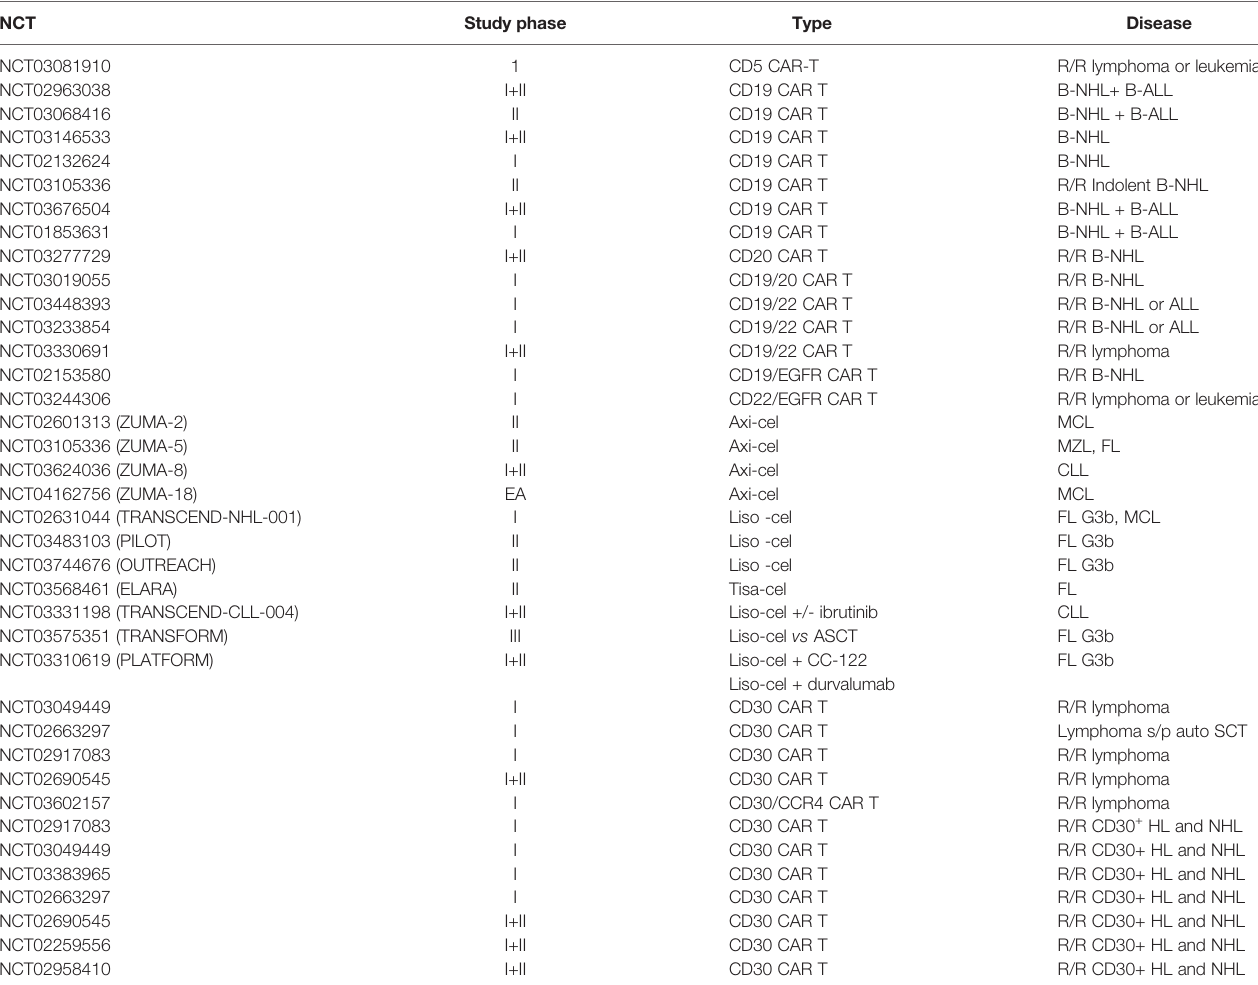
TABLE 3 | The clinical trials of CAR-T cell therapies in